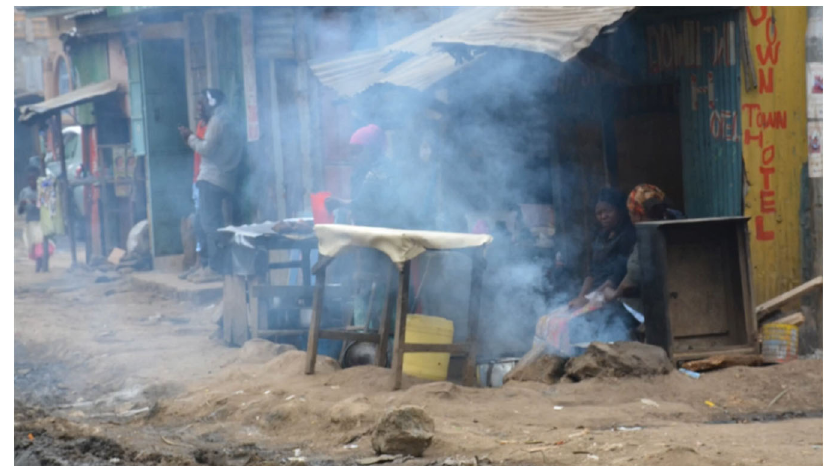
Fig. 7 Still from Dennis Waweru ’ s digital story exploring air pollution in Mukuru. The full digital story is available in Supplementary